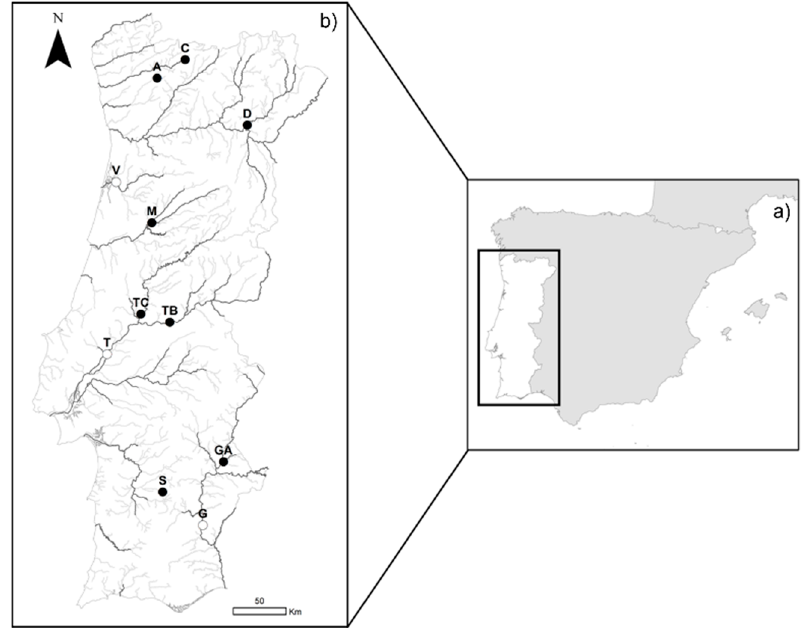
Figure 1. Map showing locations of pikeperch Sander lucioperca populations in ( a ) Iberian Peninsula and ( b ) mainland Portugal. White circles correspond to lotic populations and black ones to lentic populations. From north to south (Drainage—Location/Habitat): C, Cávado River—“Alto do Rabagão” reservoir; A, Ave River—“Ermal”—reservoir; D, Douro River—“Foz do Sabor” reservoir; V, Vouga River—lotic section near “Angeja”; M, Mondego River—“Aguieira” reservoir; TC, Tagus River—“Castelo de Bode” reservoir; TB, Tagus River—“Belver” reservoir; T, Tagus River—lotic section near “Santarém”; S, Sado River—“Penedrão” reservoir; GA, Guadiana River—“Alqueva” reservoir; G, Guadiana River—lotic section near “Mértola”.